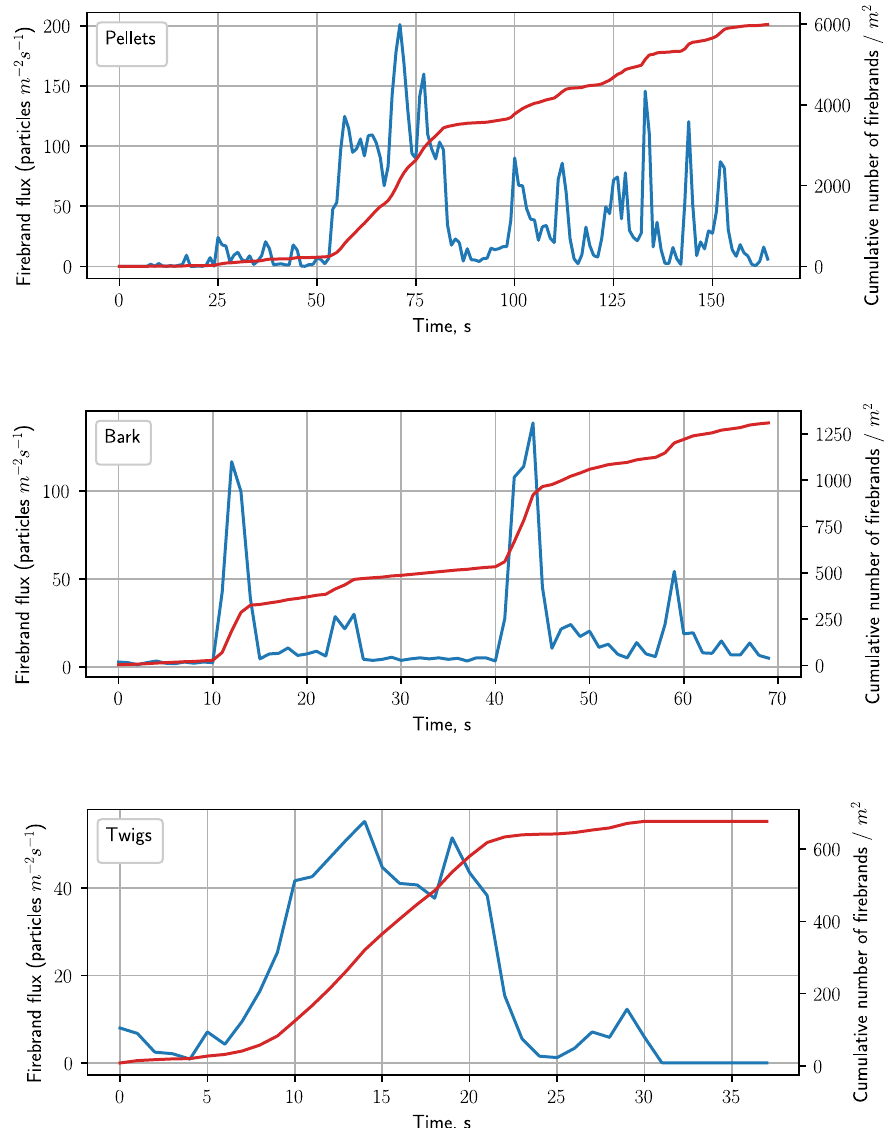
Figure 10. Firebrand flux during the test period (left axis, blue line) and the total number of firebrands per m 2 (right axis, red line).